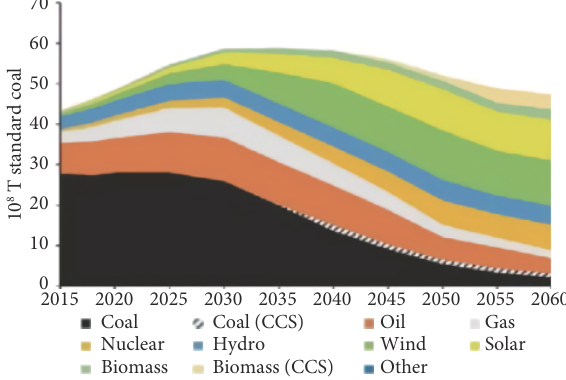
Fig. 2 Total amount and structure of China’s primary energy consump- tion (reprinted with permission from Ref. [3], © Xiliang Zhang) .